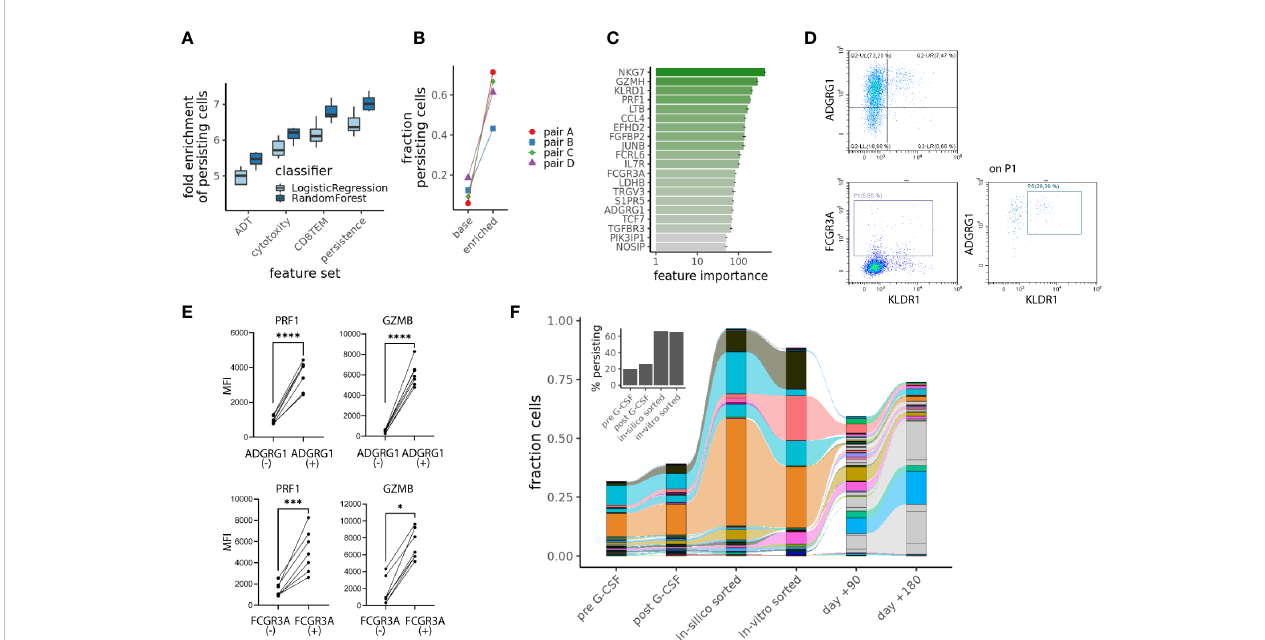
FIGURE 5 Identifying persisting CD8TEM cells with cytotoxic features in the donor. (A) Enrichment of persisting cells using different machine learning approaches and 4 different feature sets: antibody-derived tags ( “ ADT ” ), “ Cytototoxicity ” comprising cytotoxicity genes (26), “ CD8TEM ” comprising 50 markers for the CD8TEM population (24) and “ persistence ” including 54 genes differentially expressed in persisting CD8TEM. Boxes indicate interquartile range from 10fold cross-validation with a 75:25 train:test split across all ~26000 cells. (B) Results for the random forest model with 54 persistence genes when training on 3 donors and evaluating on the fourth. (C) Most informative features for the random forest model using 54 persistence genes. (D) Flow cytometric assessment of the surface marker ADGRG1, KLDR1 and FCGR3A on CD8TEM (% expression). (E) Flow cytometric assessment of the cytolytic molecules perforin (PRF1) and granzyme B (GZMB), linear graphs for fi ve donors comparing CD8TEM with vs. without expression of ADGRG1 or FCGR3A. Illustrated are the Mean Fluorescence Intensities (MFI). P-values from t-test, *p < .05, ***p < .001, ****p < .0001 (F) Sorted ADGRG1+CD8TEM from donor of pair B were analyzed by TCR b bulk sequencing and clonotypes with TCR b chains, which overlapped with our persisting T cell clonotypes from the scRNAseq analysis are shown. Inset shows the percentage of persisting cells in donor